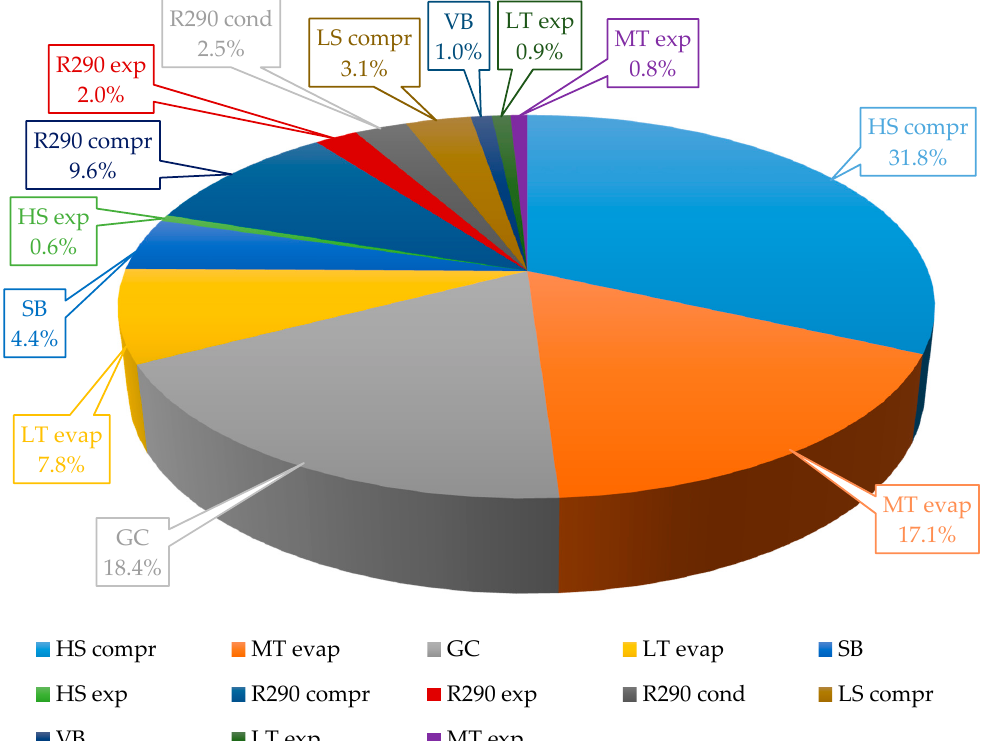
Figure 5. Breakdown of the contribution (%) of each component belonging to DMS to the total avoidable exergy destruction rate at the outdoor temperature of 40 °C.